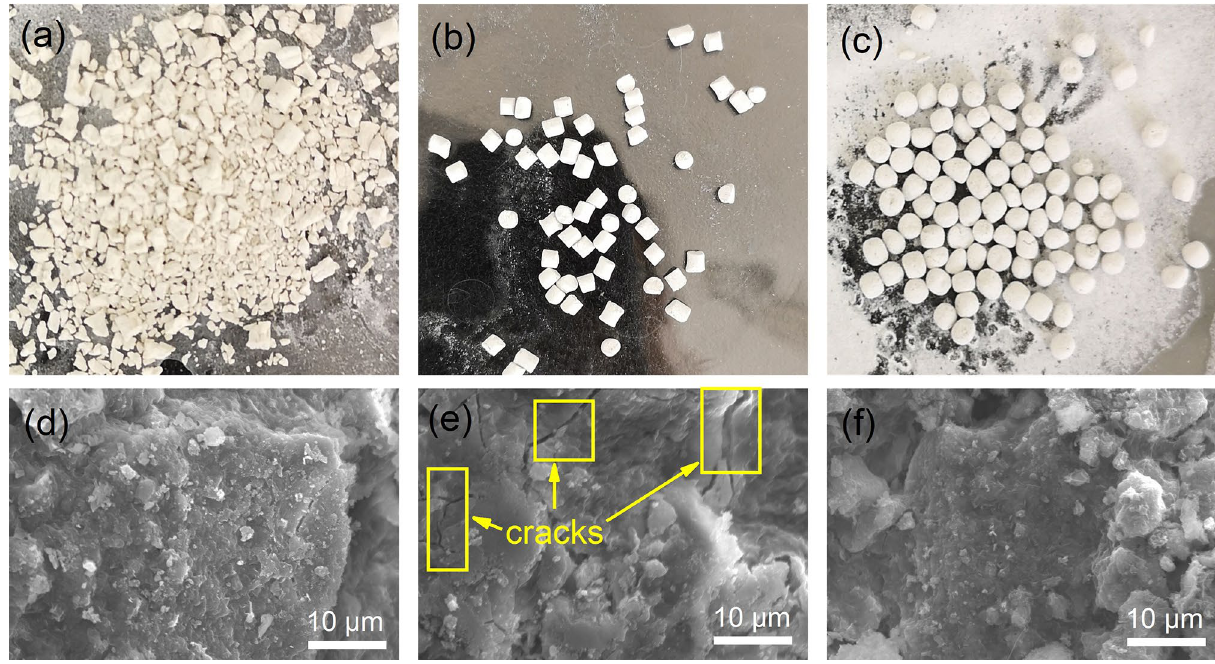
Figure 2. ( a – c ) Appearance after loss rate experiments with typical particles and ( d – f ) SEM images of typical particles: ( a ), ( d ) 9:1 particles, ( b ), ( e ) 5:5 particles, and ( c ), ( f ) 1:9 particles.